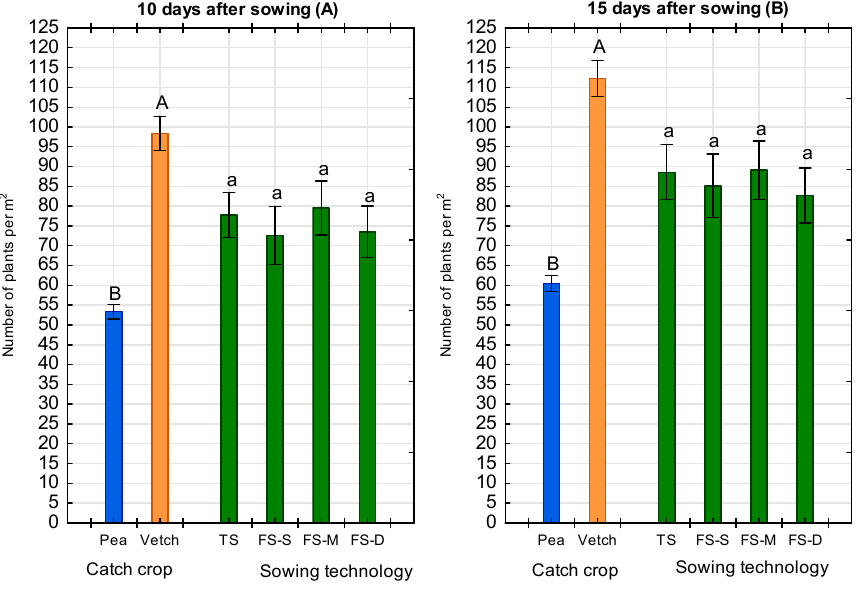
Figure 7. Plant density 10 ( A ) and 15 ( B ) days after sowing seeds [pcs · m − 2 ]—average for 2016–2018. a—the same small letter for different sowing methods indicates the lack of significant differences between means ( p = 0.05). A,B—different capital letter for different crops indicates significant differences between means ( p = 0.05).